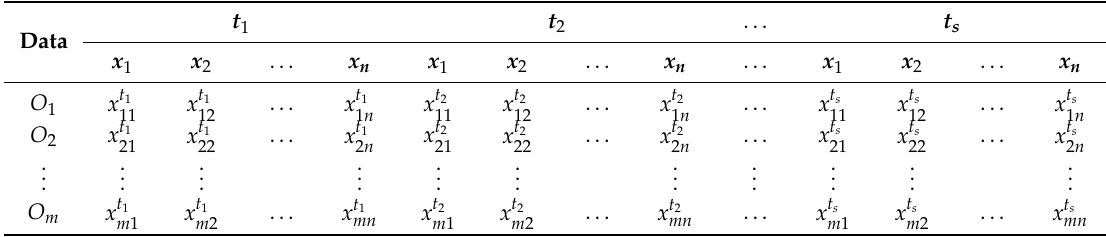
Table 1. The data sets of urban underground space